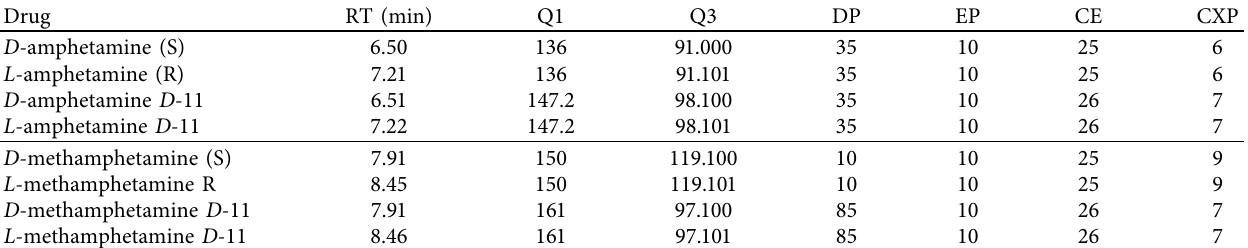
Table 11: Transitions and retention times for D- and L- amphetamine and methamphetamine. Drug